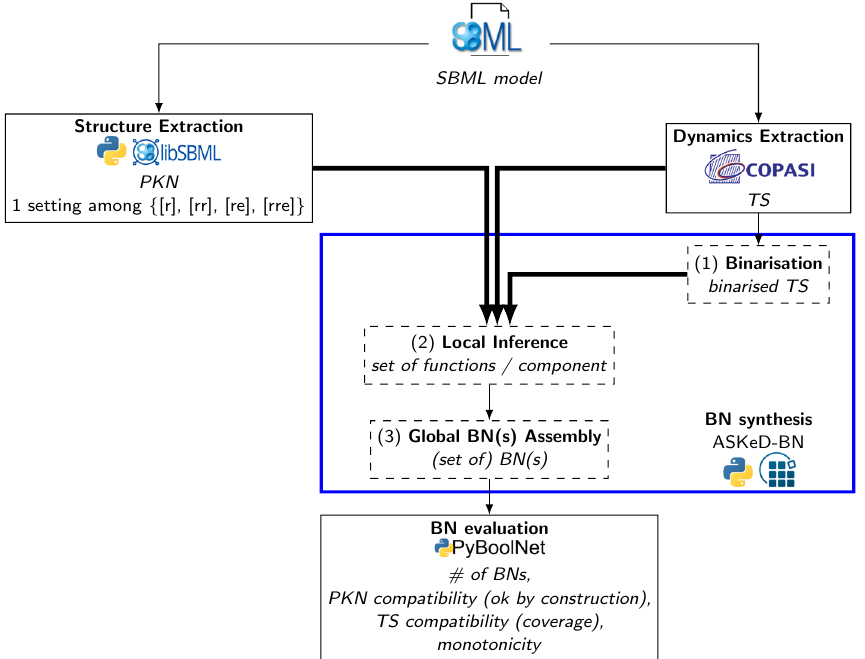
Fig. 3 Workflow of the SBML2BN pipeline. The BN synthesis step (blue box) is composed of 3 steps among which the local inference of the transition functions which uses 3 inputs (thick arrows): a PKN, a TS, and its